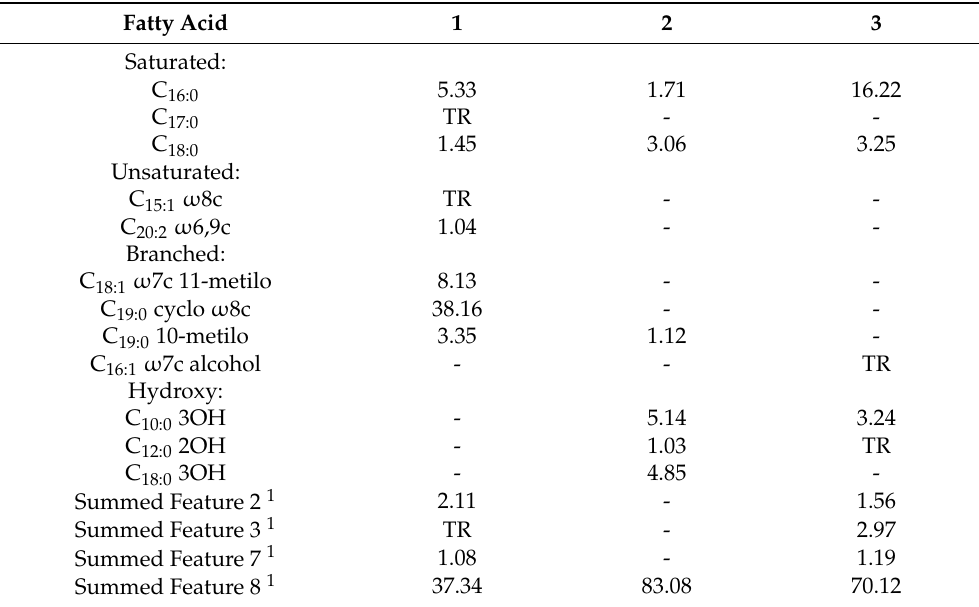
Table 2. Cellular fatty acid composition (%) of strain ASV31 T and its closely phylogenetic related taxa determined under the same conditions. Strains: 1, ASV31 T ; 2, Thioclava pacifica DSM 10166 T ; 3, Rhodovulum algae LMG 29228 T . All data from this